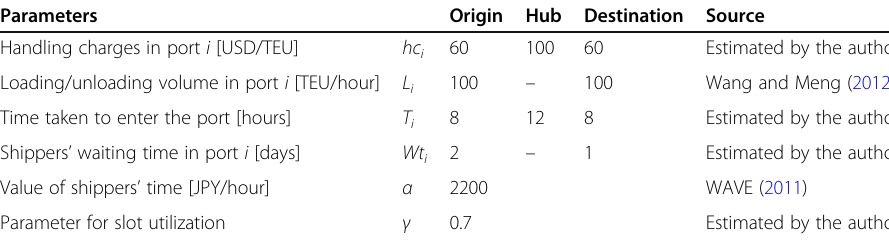
Table 1 Input parameters in simulation